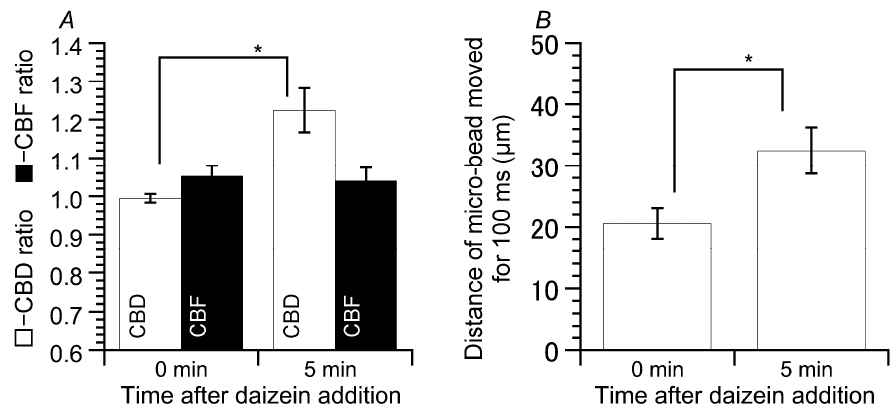
Figure 8. Effects of daidzein on microbead movements. ( A ) Changes in CBD and CBF before and five minutes after daidzein stimulation. The cHNECs were first perfused with the CO 2 /HCO 3 − -containing control solution for five minutes, and then with the CO 2 /HCO 3 − -free control solution for further five minutes. Stimulation with daidzein increased CBD, but not CBF. ( B ) Enhancement of microbead movement by daidzein stimulation. Daidzein stimulation enhanced the microbead movement. * significantly different ( p < 0.05).